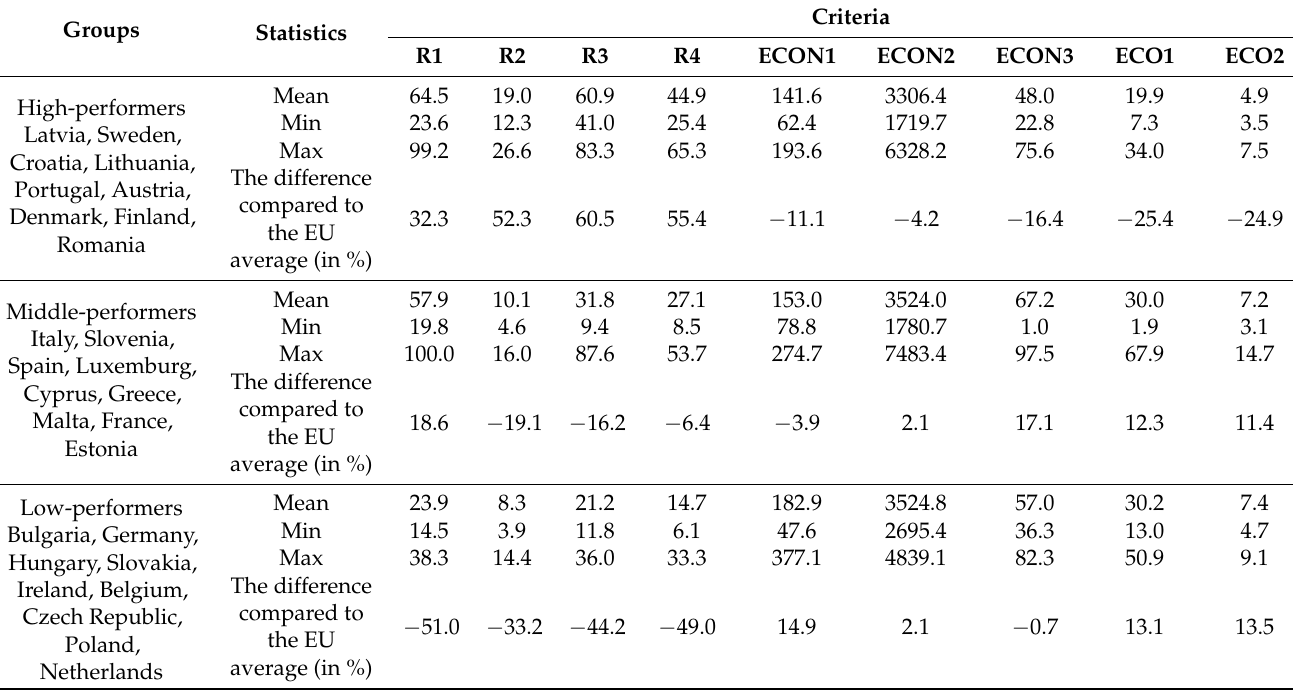
Table 7. The characteristics of derived groups of countries in